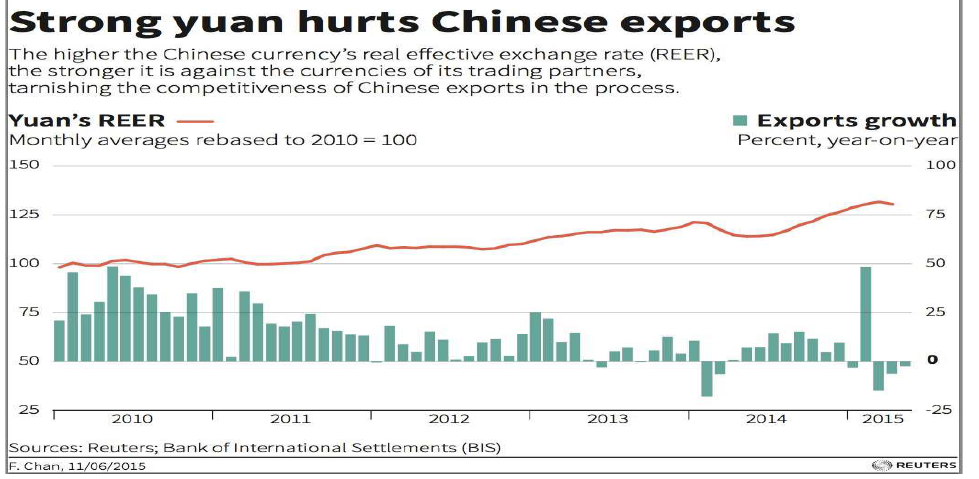
Fig. 3. A strong yuan hurts chinese